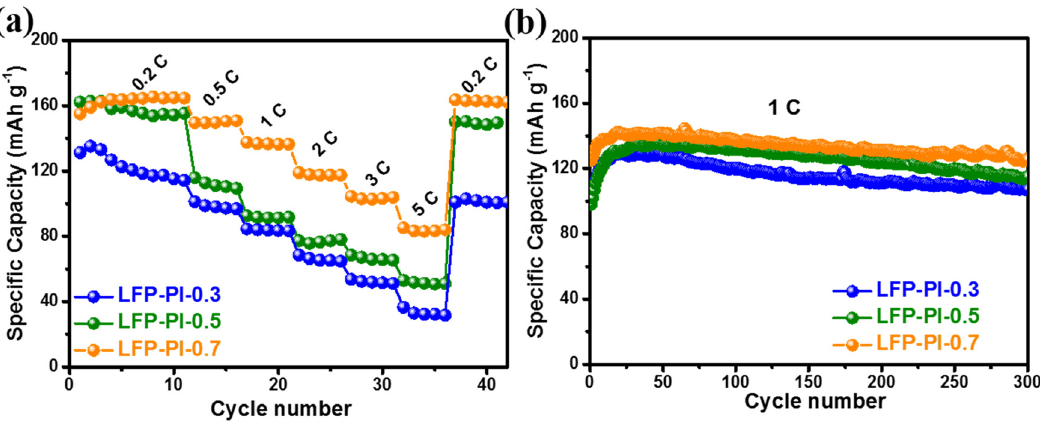
Figure 6: ( a ) Rate capabilities and ( b ) cycling performances at 1C of LFP – PI - 0.3, LFP – PI - 0.5, and LFP – PI - 0.7